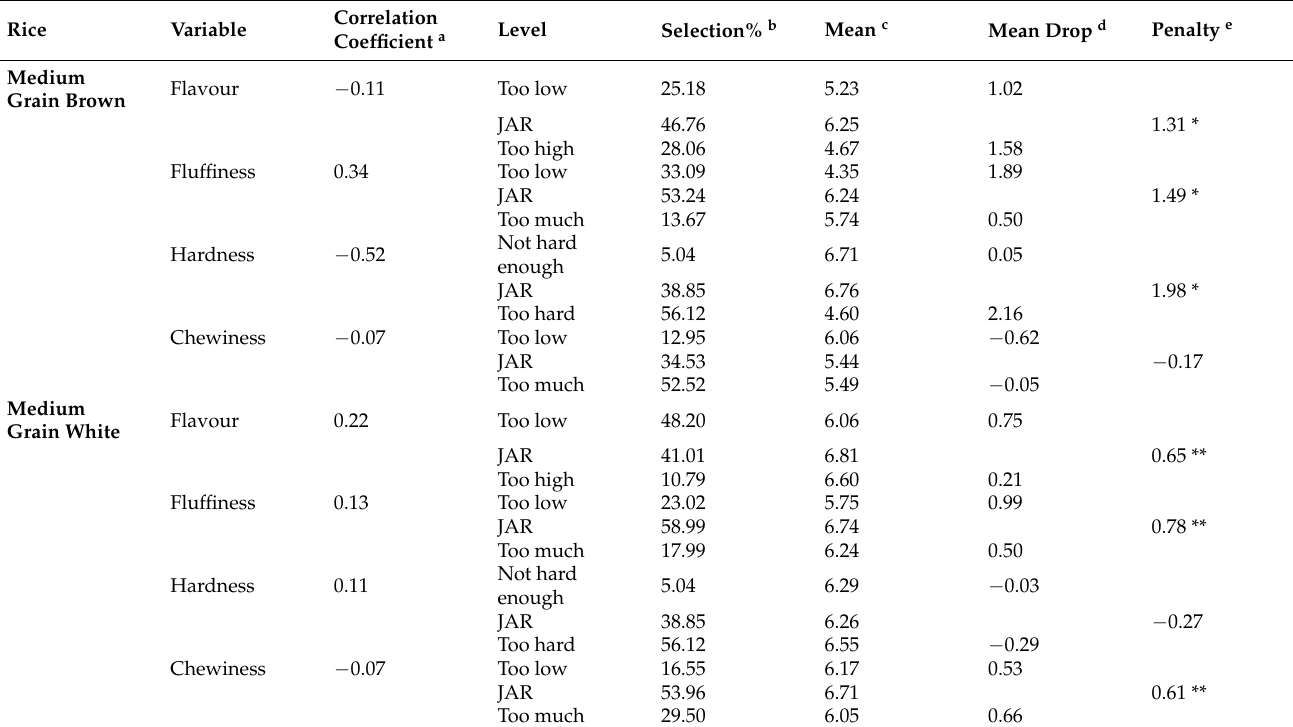
Figure 6. Mean drop plots for Low GI rice variety after tasting ( A ) Low GI Brown and ( B ) Low GI White. * Mean drop is the decrease in liking compared to the mean liking of those who rated the attribute as JAR. ** Consumer % are the consumers which judged an attribute as not ideal (Just About Right). The attributes with large percentages of consumers and penalties are in top right quadrant of the plot, which illustrates the critical points of the product [34]. Table 10. The Penalty analysis and JAR variables (after tasting) for Medium Grain brown and white